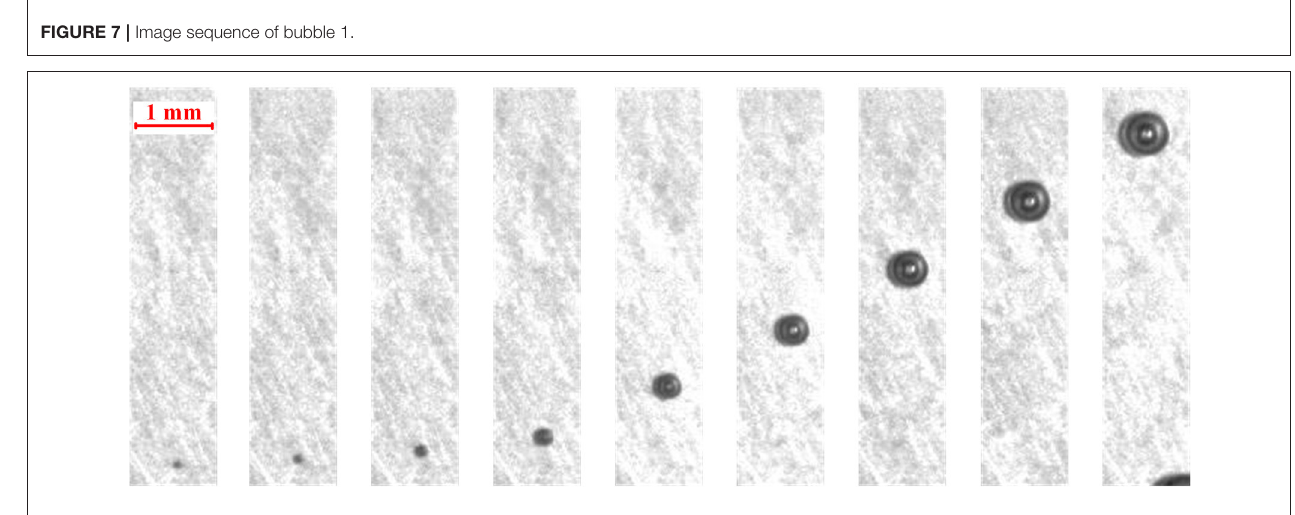
FIGURE 8 | Image sequence of bubble 2.